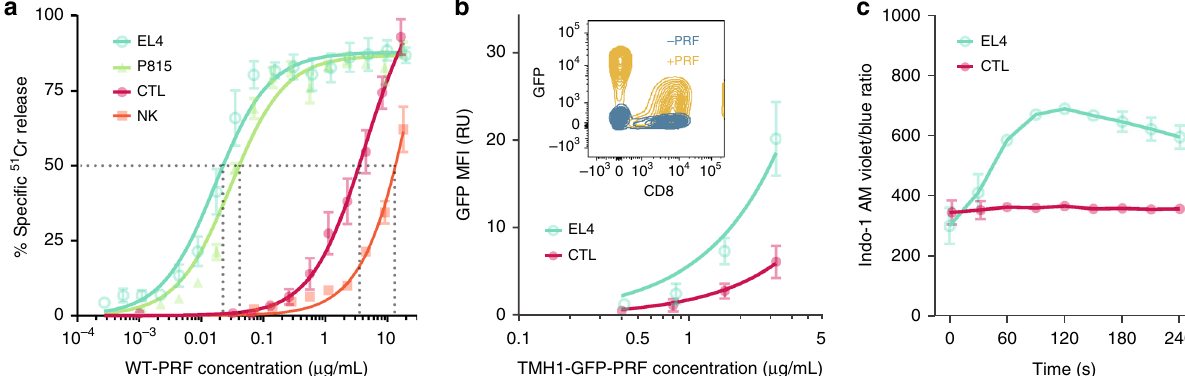
Fig. 1 CTLs bind less perforin and resist pore formation. a 51 Cr release cytotoxicity assay on CTLs, natural killer (NK) cells, and EL4 and P815 target cells upon exposure to recombinant WT-PRF. CTLs are 2 – 3 orders of magnitude more resistant than target cells, as assessed at 50% 51 Cr release (dotted lines). Curves represent Michaelis – Menten fi ts to the data. b Binding of TMH1-GFP-PRF to a 1:1 mixture of CTL and EL4 cells, as assessed by fl ow cytometry, with GFP geometric mean fl uorescence intensity (MFI) measured in relative units (RU). The cells were stained with anti-CD8-allophycocyanin (APC) prior to fl ow cytometry to differentiate the two cell types. The comparison was made for CTL and EL4 cells of the same size, as derived from forward and side scatter. Curves represent Michaelis – Menten fi ts to the data. Inset: example of fl ow cytometry data with TMH-GFP-PRF staining of a 1:1 mixture of CD8 + (CTL) and CD8 − (EL4) cells. c Ca 2 + in fl ux into Indo-1 AM labelled CTL and EL4 cells upon exposure to sub-lytic amounts of WT-GFP-PRF. Membrane perforation by perforin was measured via the Ca 2 + in fl ux over time, detected as an increase in the ratio of violet (400 nm) to blue (475 nm) fl uorescence emission; WT-GFP-PRF was added at t = 0. See Supplementary Fig. 1b, c for control experiments that demonstrate similar levels of perforin binding to both cell types, as well as the speci fi city of the observed difference to perforin. Curves provide a visual guide connecting data points. Throughout the panels, each data point represents a mean ± standard error of mean (s.e.m.) of three independent experiments. Source data for all panels are provided as a Source Data fi